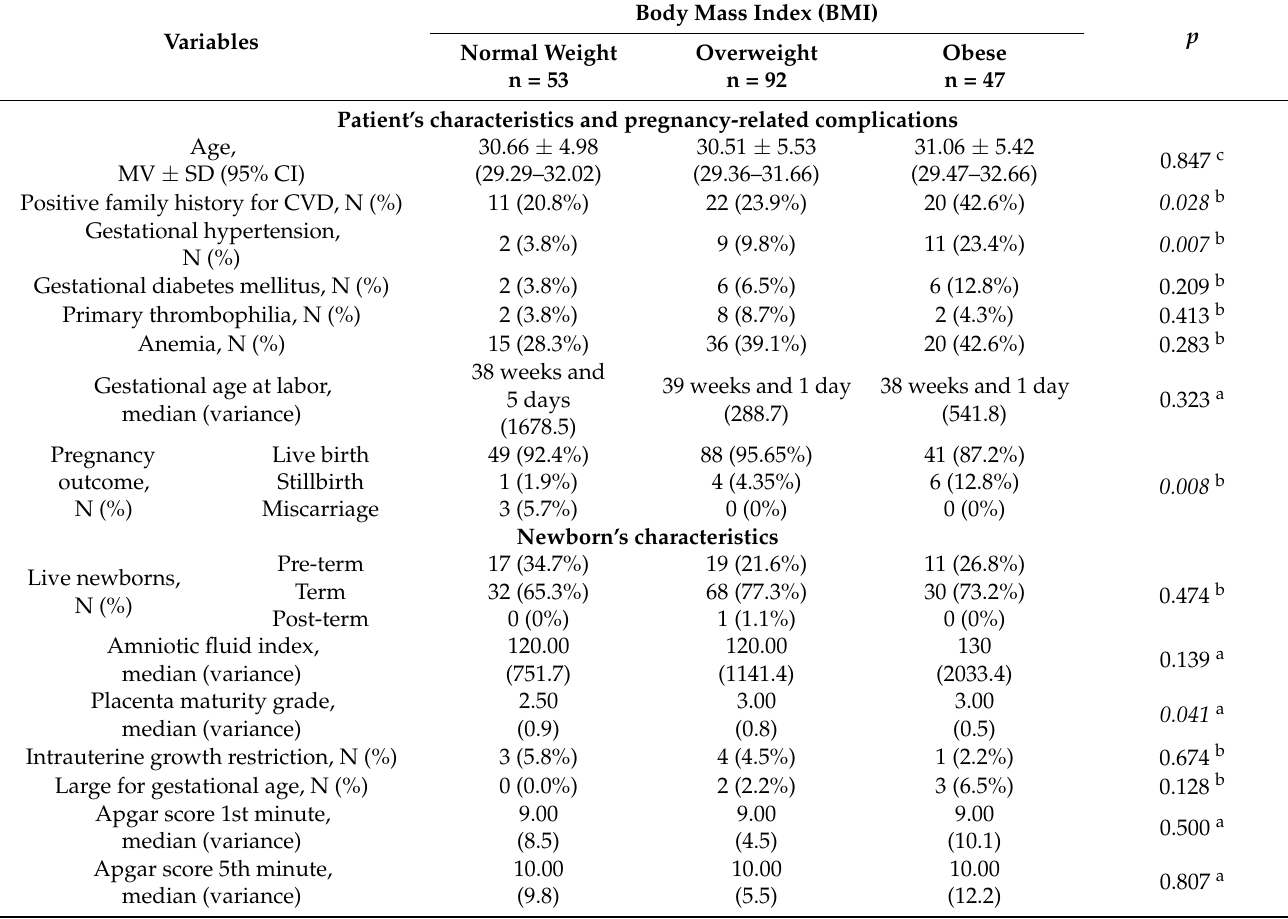
Table 1. Clinical features of pregnant women with COVID-19 by body mass index